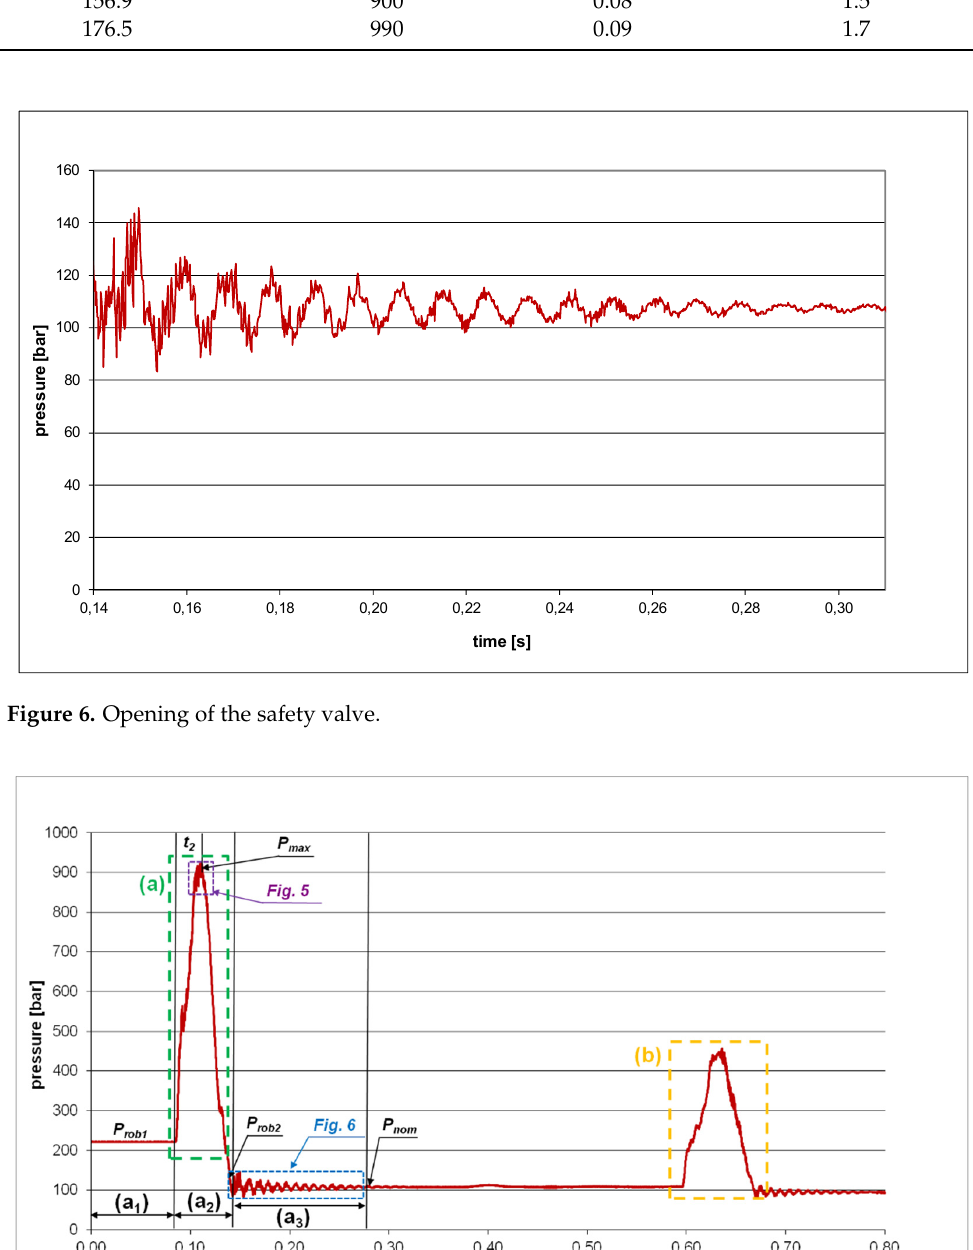
Figure 7. Increase in fluid pressure under load in progress. 820840 860 880 900